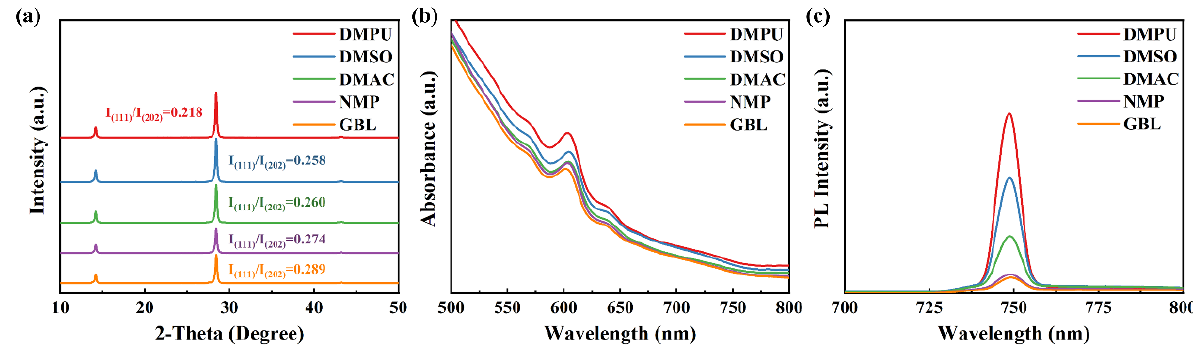
Figure 1. ( a ) XRD patterns, ( b ) UV–Vis absorption, and ( c ) PL spectra of the perovskite films prepared with different solvents.